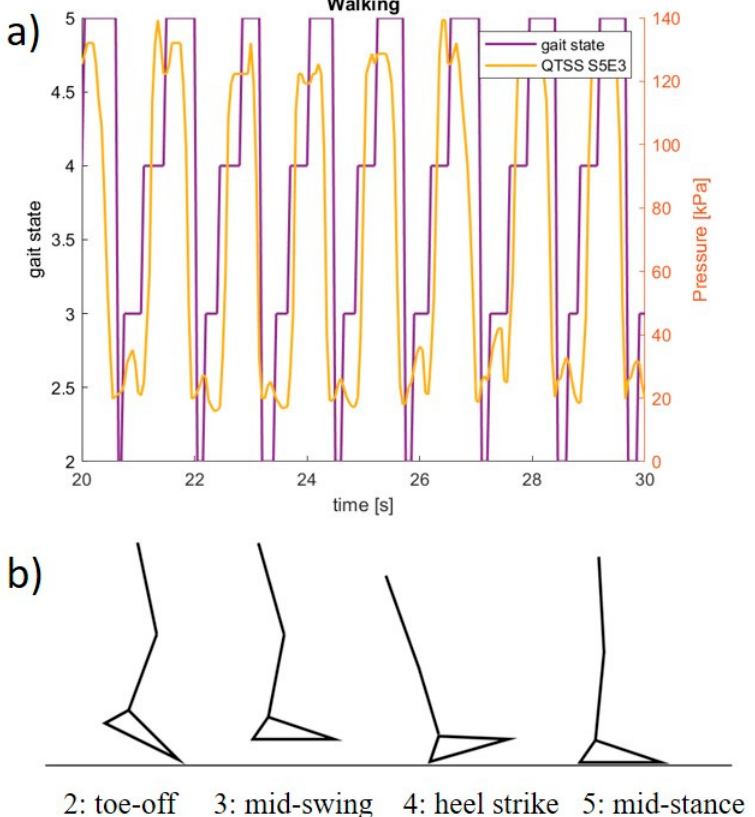
Figure 20. ( a ) An example of a pressure reading output from one sensel on a QTSS™ pressure sensor strip during an initial pilot trial walking gait cycle. ( b ) Gait states: 2 = toe-off, 3 = mid-swing, 4 = heel strike, 5 = mid-stance.